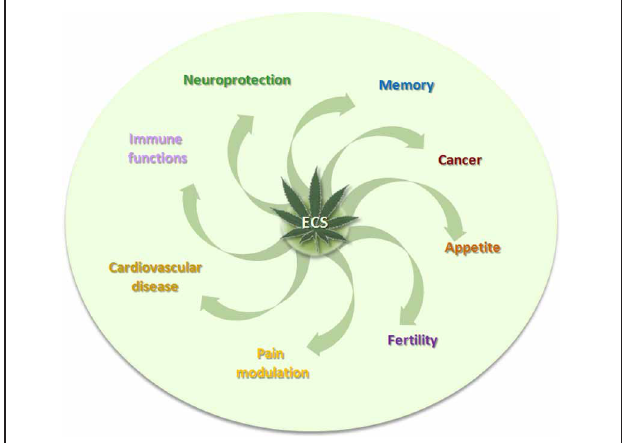
FIGURE 3 | The involvement of ECS in some pathophysiological